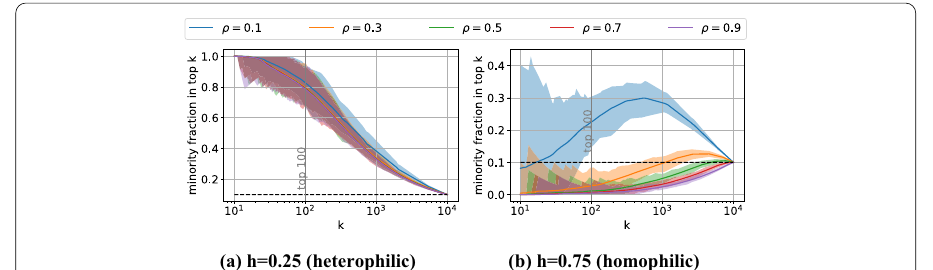
Fig. 7 Sensitivity of our results with regard to the choice of k. We visualize the fraction of the minority in the top k ranked nodes as a function of k, for different retain rates for majority associated noise. The solid line is the mean while the enveloping curve represent the range of values obtained in 10 iterations. Ties are resolved randomly. Due to large noise for the top ranked position we only start visualising for k > 10. We see that the effects displayed in Fig. 3 for k 100 are representative for a wider range of k values =